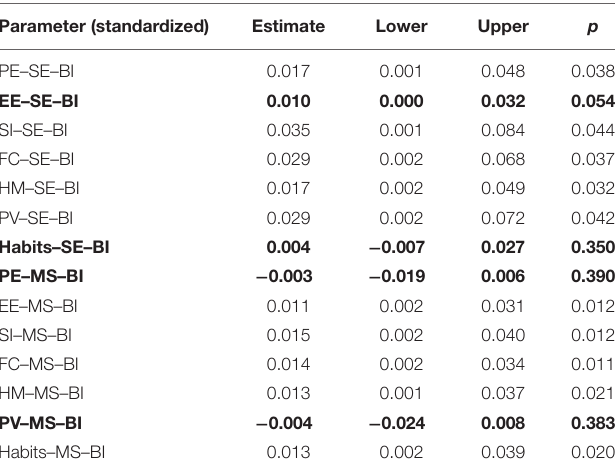
TABLE 7 | Mediating effects of study